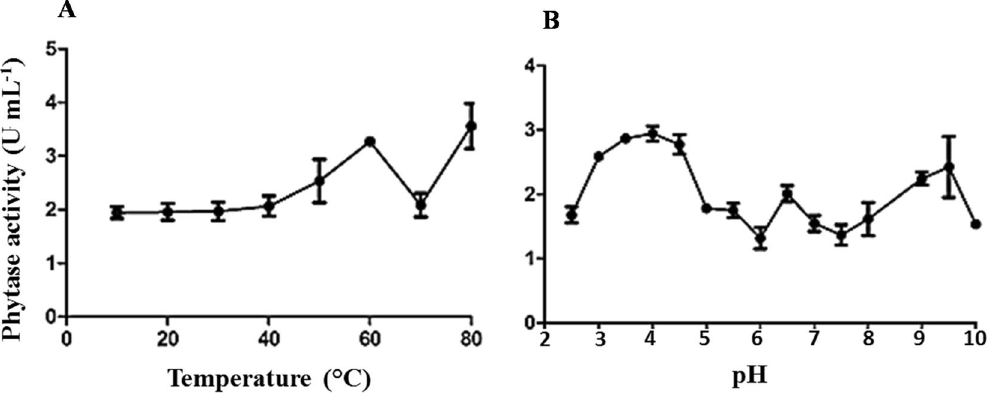
Figure 7. Phytase activity in Kluyveromyces marxianus extracts at different temperatures ( A ) and pH values ( B ). The bars correspond to the standard deviations of the means (n = 3).